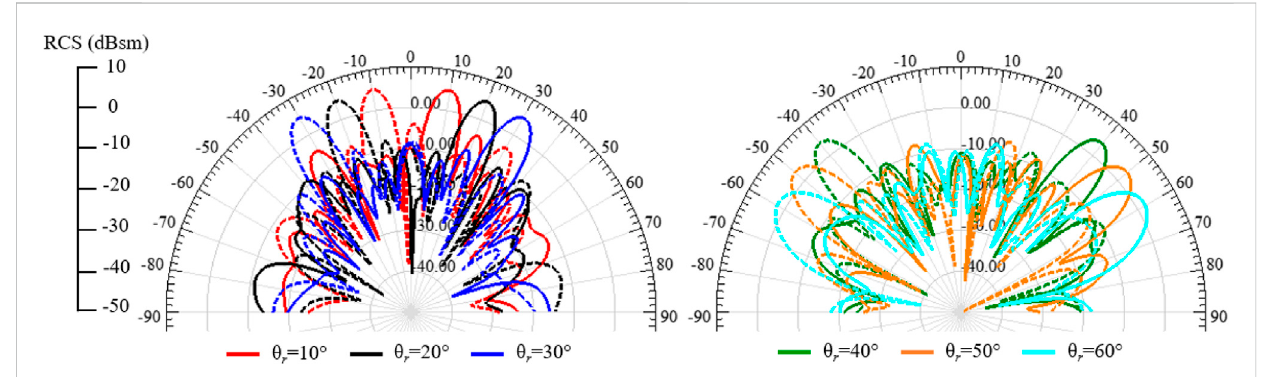
FIGURE 12 Simulated RIS RCS patterns under normal plane wave illumination for various re fl ection